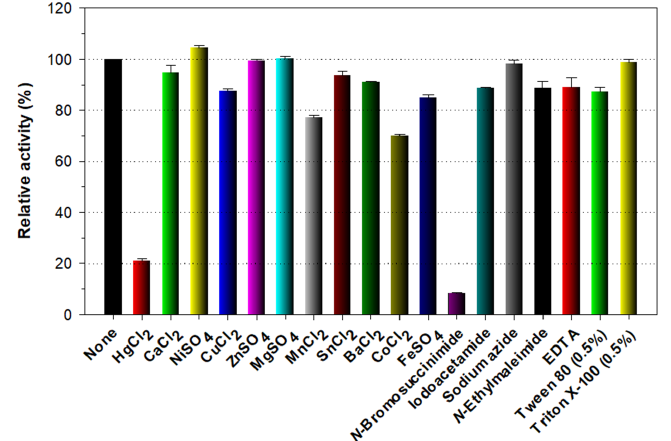
Figure 4. Effects of metal ions (1 mM) and chemical reagents (5 mM) on the endo- β -1,3-glucanase activity of rGluY. The values are mean ± SD of triplicate tests.